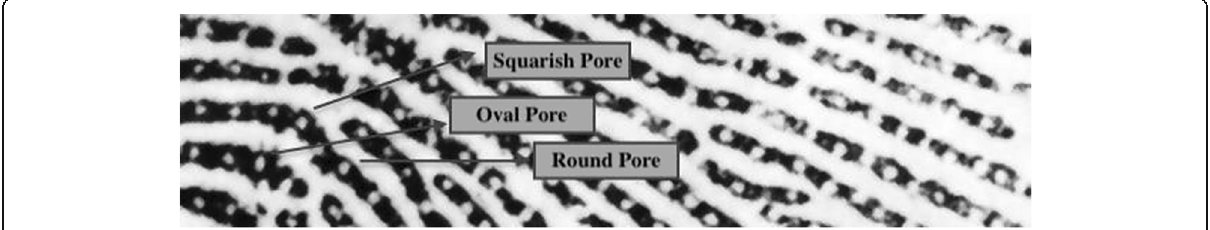
Fig. 2 The photomicrographic image of rolled friction ridge impressions showing different shapes of the sweat pores present on an individuals friction ridges